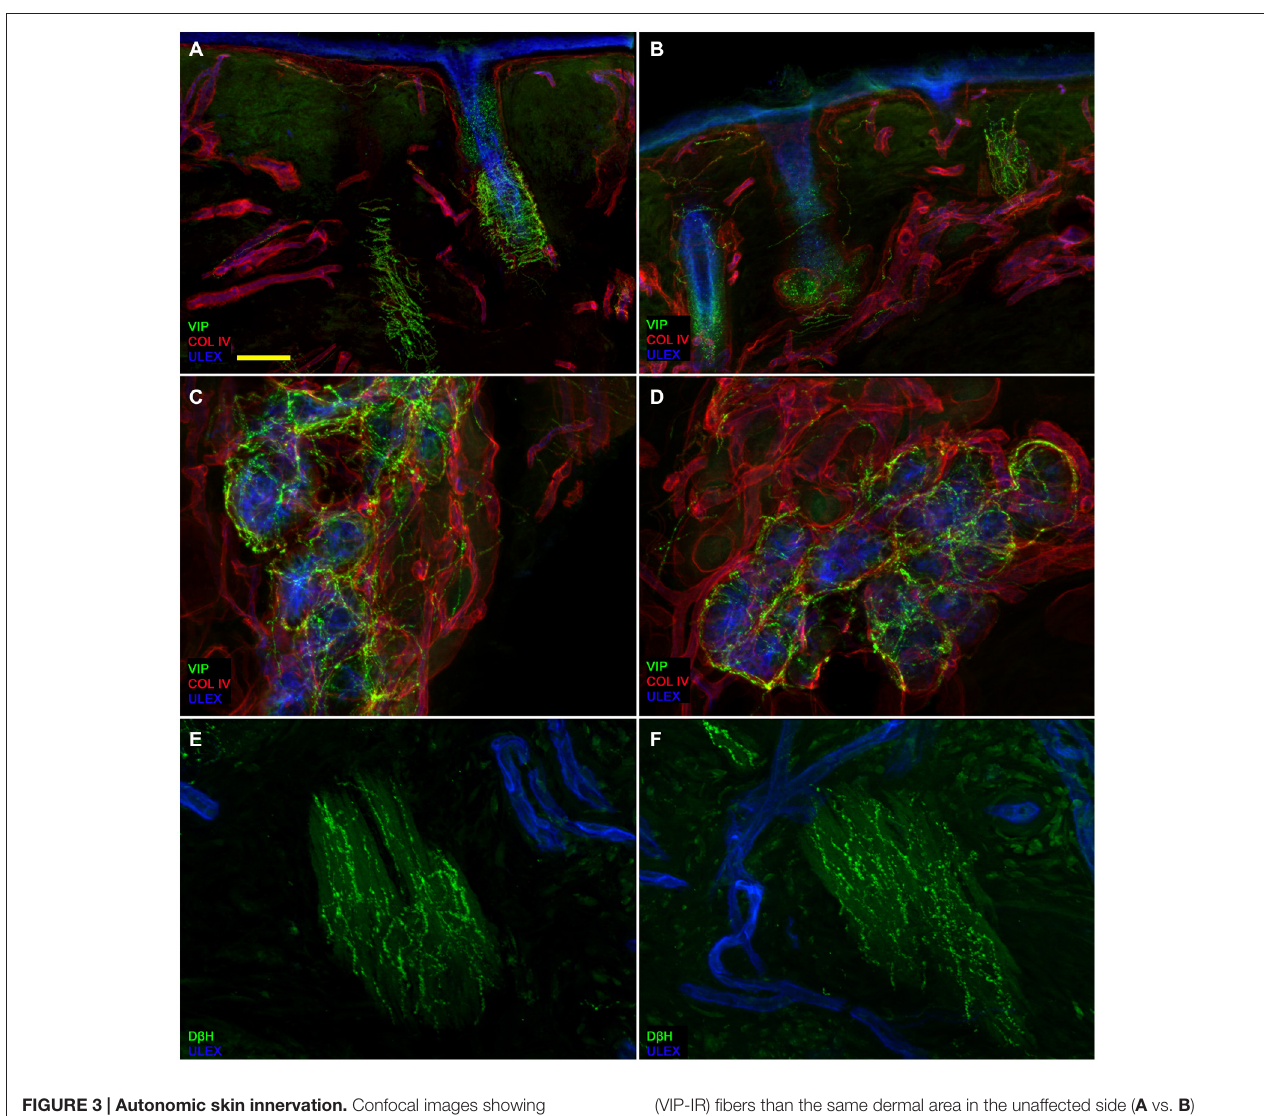
FIGURE 3 | Autonomic skin innervation. Confocal images showing Autonomic innervation to dermal annexes in the affected (A,C,E) and unaffected side (B,D,F) . The upper dermis around hair follicles in the affected side contains fewer vasoactive intestinal peptide-immunoreactive